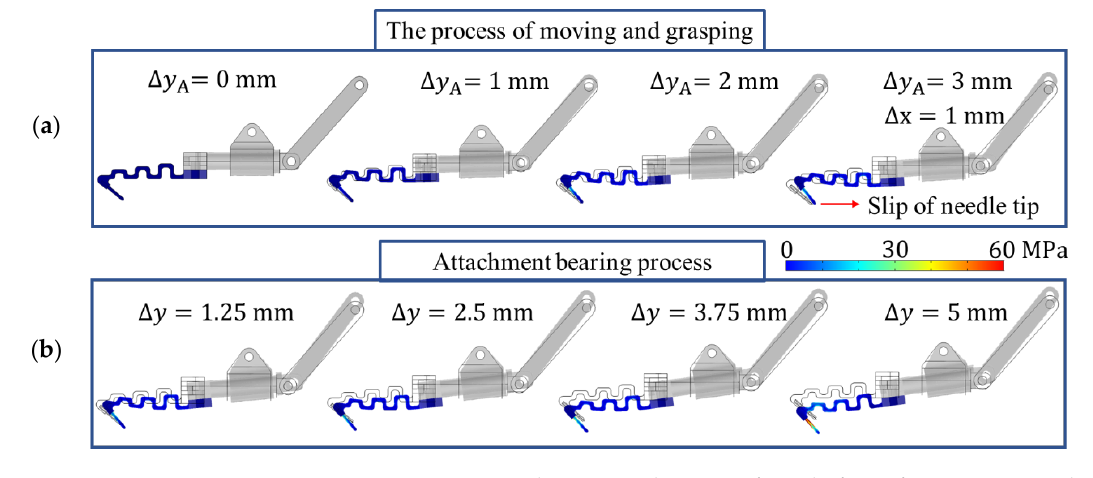
Figure 6. Action sequence and stress nephogram of single foot of microspine in the process of grasping and attaching. ( a ) Actuate the grasping process. ( b ) Attachment loading process.